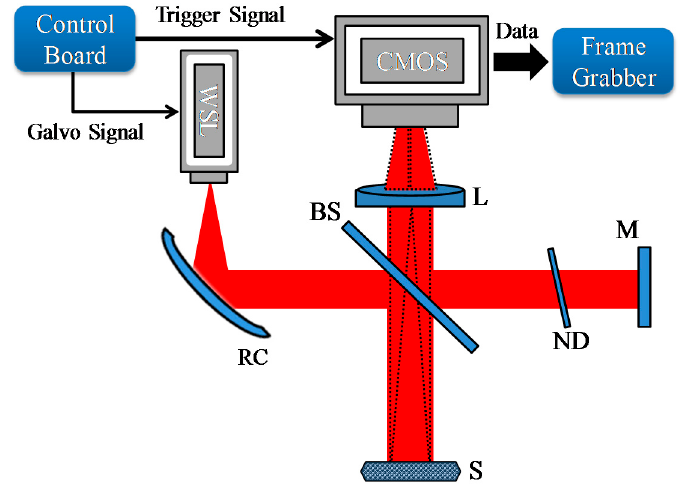
Figure 3. Schematic diagram of a full-field OCT system. BS: pellicle beam splitter, CMOS: complementary metal oxide semiconductor, L: lens, M: mirror, ND: neutral density filter, RC: reflective collimator, S: sample, WSL: wavelength swept laser.